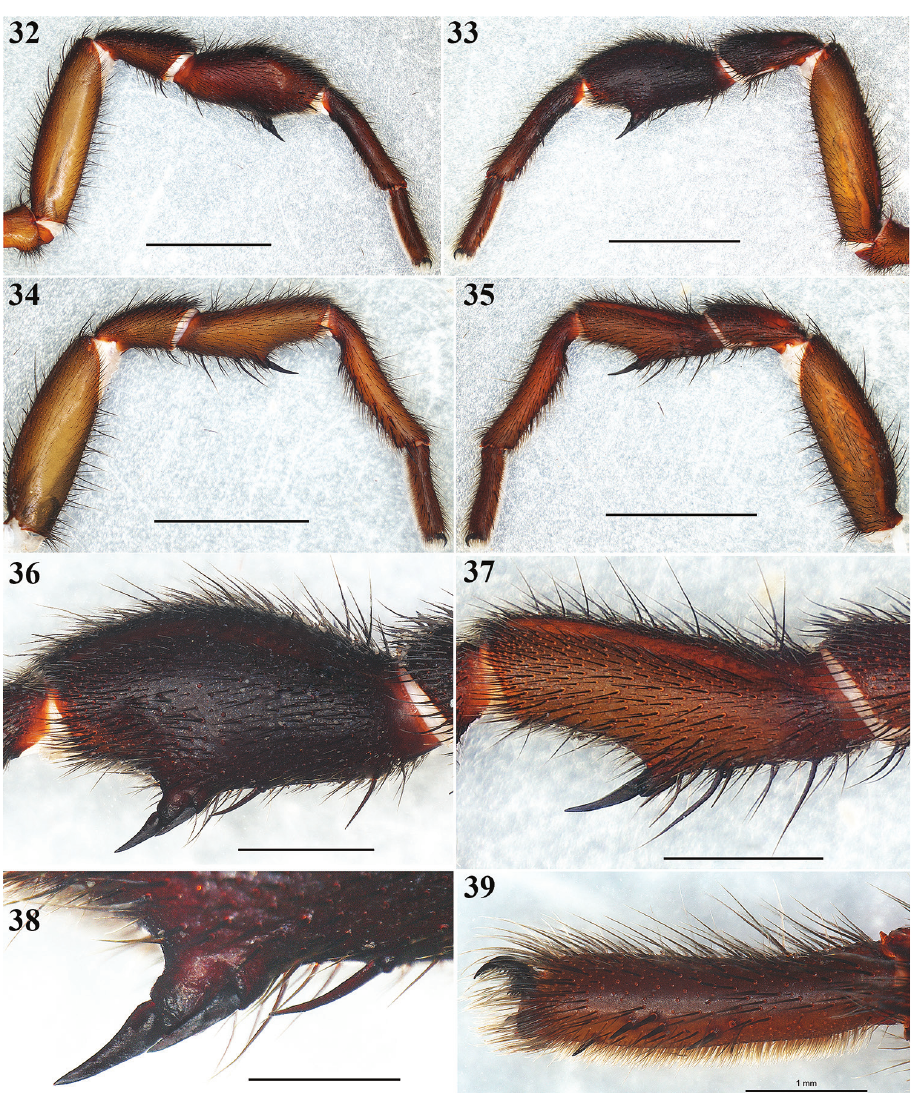
Figures 32–39. Eucteniza zapatista Bond & Godwin, 2013. Male: 32–33 Left leg I, prolateral and retrolateral views respectively 34–35 Left leg II, prolateral and retrolateral views respectively 36 Tibia I, retrolateral view 37 Tibia II, retrolateral view 38 Detail of the paired megaspines on tibia I 39 Scopulae on tarsus I, retrolateral view. Scale bars 1 mm ( 38 , 39 ), 2 mm ( 36 , 37 ), 5 mm ( 32–35 ). (Fig. 24). Posterior sternal sigilla large and elongate, medial pair of anterior sigilla moderate in size, anterior pair small and marginal (Fig. 24). Labium wider than long, brown, with long setae anteriorly, without cuspules (Fig. 25). Endites long and setose, with an apical-prolateral inconspicuous conical apophysis, without cuspules (Fig. 25). Chelicerae: Promargin furrow with 7 teeth, retromargin furrow with